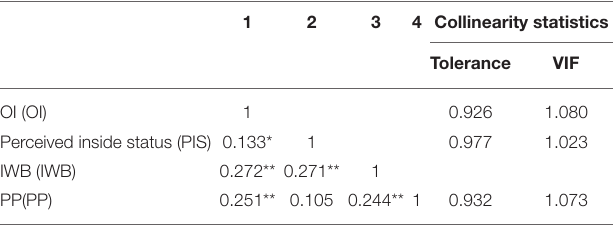
TABLE 3 | Correlation and multicollinearity